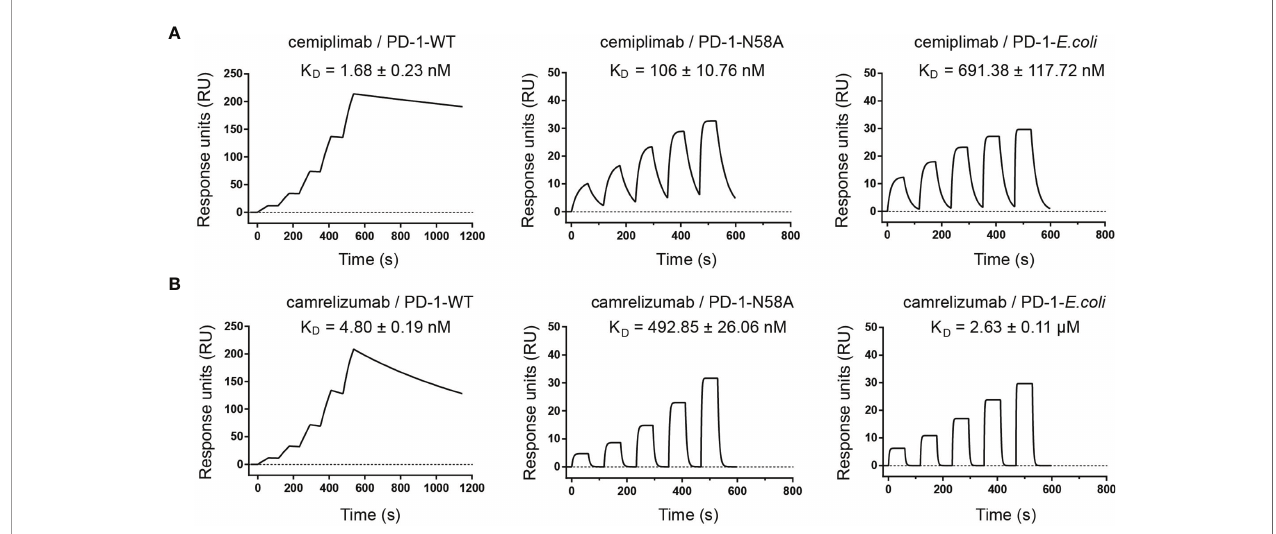
FIGURE 5 | N-glycosylation of N58 remotes the binding to cemiplimab. (A) SPR assay characterization of the binding pro fi les of cemiplimab with PD-1-WT (left), PD-1-N58A (middle) proteins expressed in 293F cells, and PD-1- E. coli (right) expressed in E. coli cells. (B) SPR assay characterization of the binding of camrelizumab with PD-1-WT (left), PD-1-N58A (middle) expressed in 293F cells, and PD-1- E. coli (right) expressed in E. coli cells. The mean value of the KD was recorded after repeating each experiment three